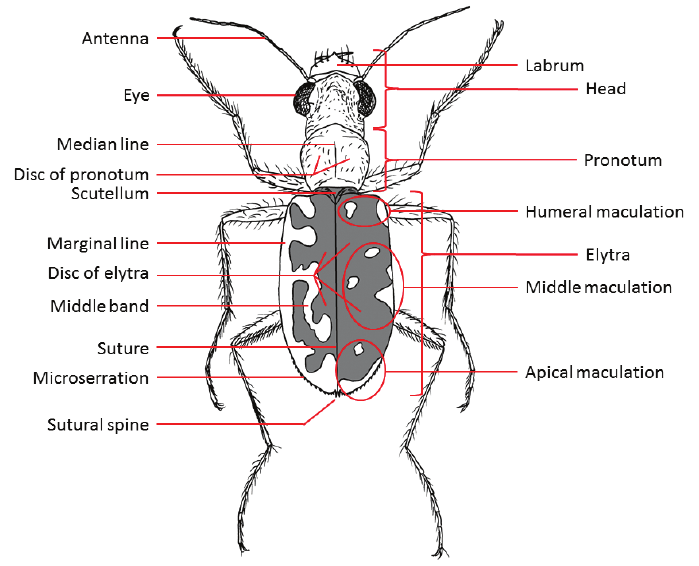
Figure 4. Habitus of a tiger beetle (dorsal view = upper side) and structures often used for